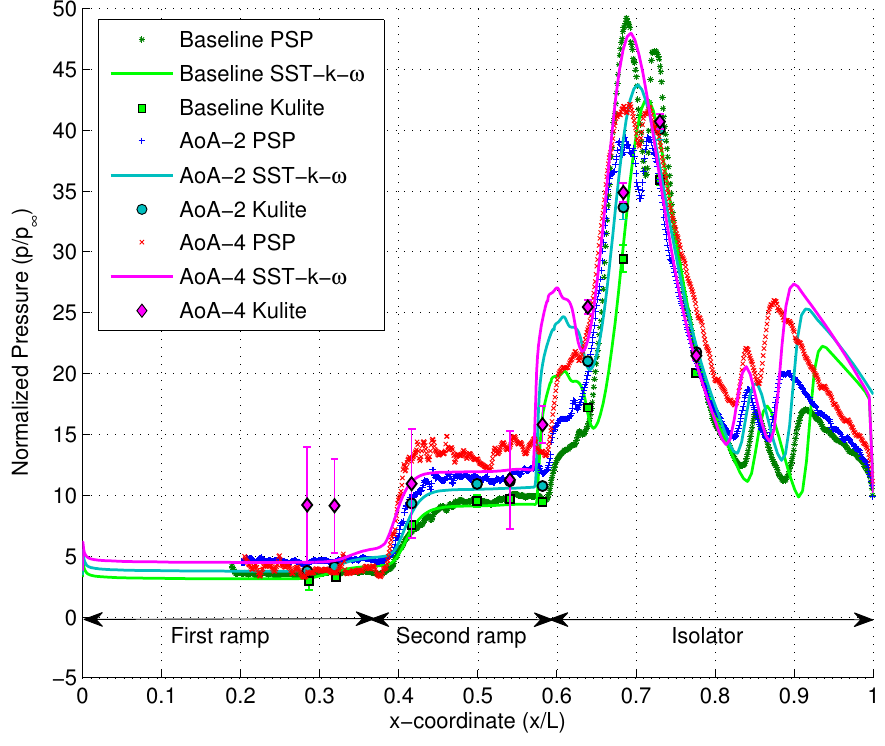
Figure 13. Normalized static pressure along the centerline of scramjet inlet model